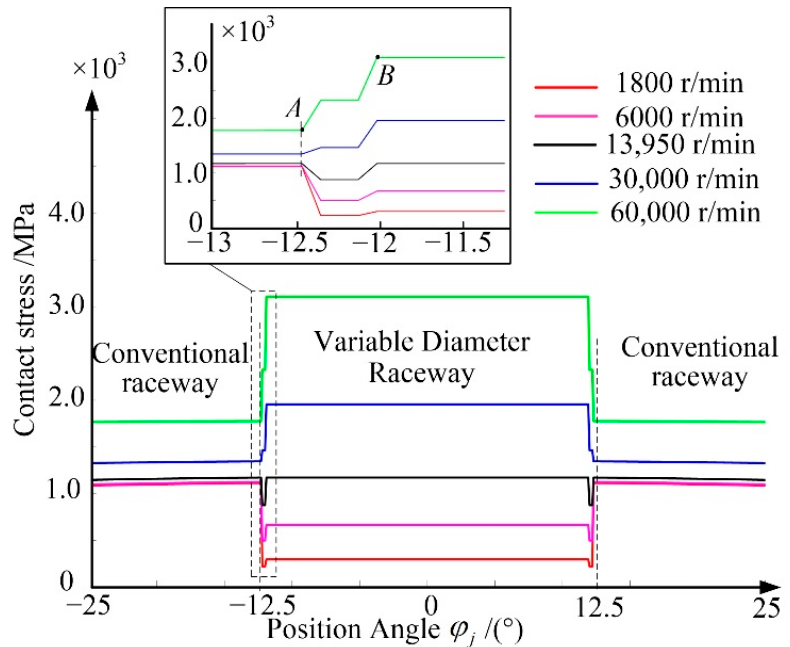
Figure 4. Relationship between contact stress and position angle for different speed.